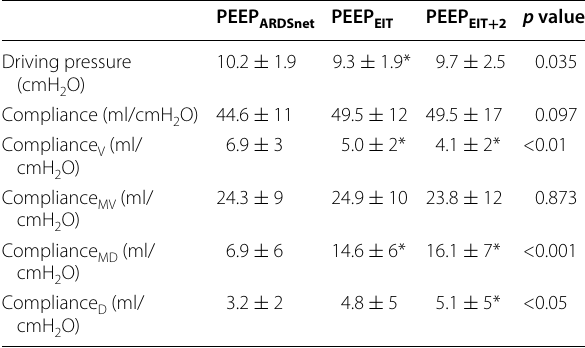
Table 2 Global and regional respiratory system compli- ance in all study